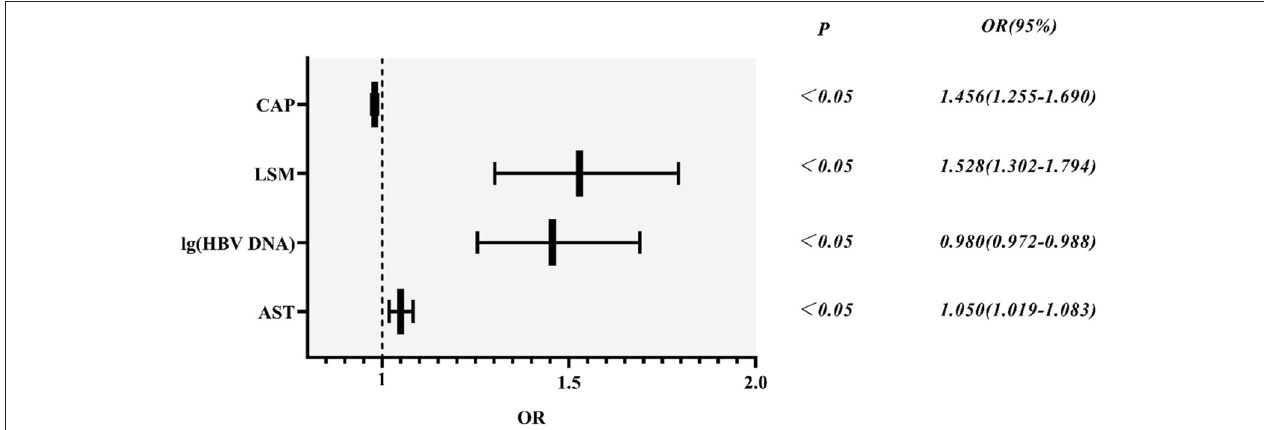
FIGURE 8 | HBV-related inflammation forest diagram in CBI patients with concurrent NAFLD. CBI, chronic HBV infection; NAFLD, non-alcoholic fatty liver disease; CAP, controlled attenuation parameter; LSM, Liver stiffness measurement; HBV DNA was calculated by denary logarithm expressed as lg (HBV DNA); AST, aspartate aminotransferase; OR/Exp(B): odds